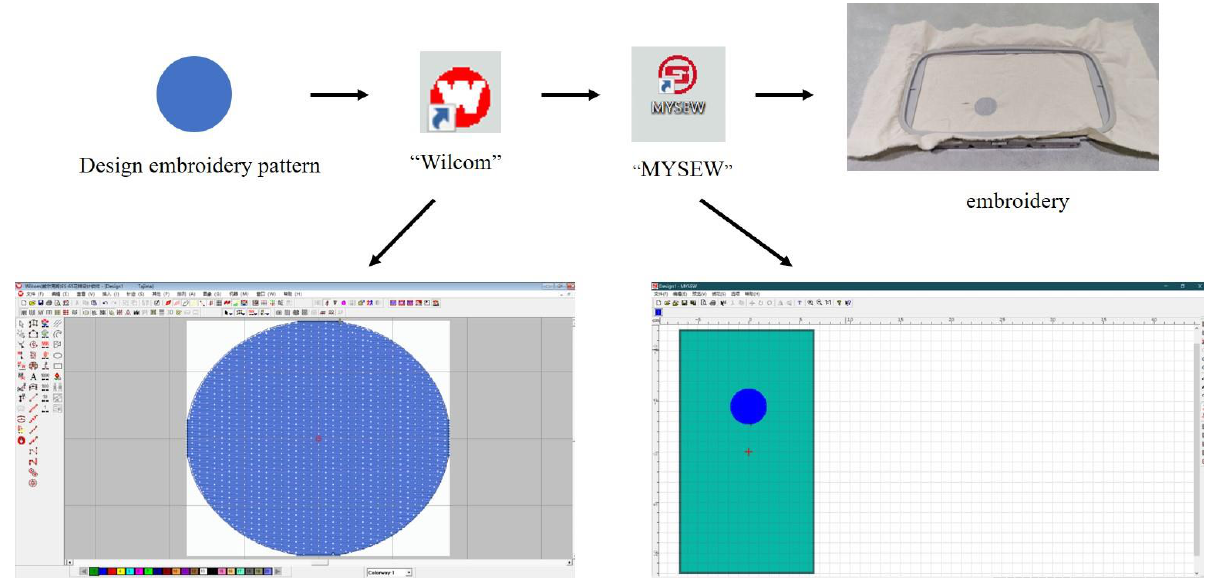
Figure 3. The embroidery process. First, design the electrode pattern and size, and save as a picture. Import the “Wilcom” [37] software. After color analysis, pin design and pin filling settings, save as an “DST “file. Use “WYSEW” to import the document into the computer and set the position to begin embroidery.